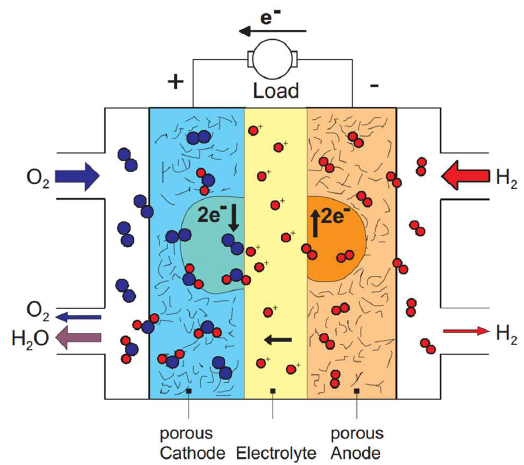
Figure 2. Schematic illustration of a hydrogen/oxygen fuel cell and its reactions based on the PEMFC. Reproduced from [44], Copyright 2001, Wiley.